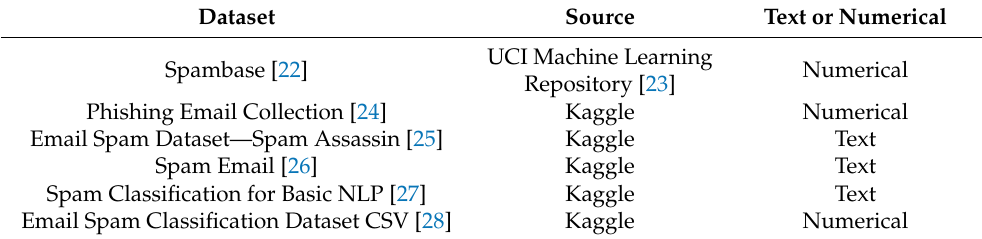
Table 1. Datasets.